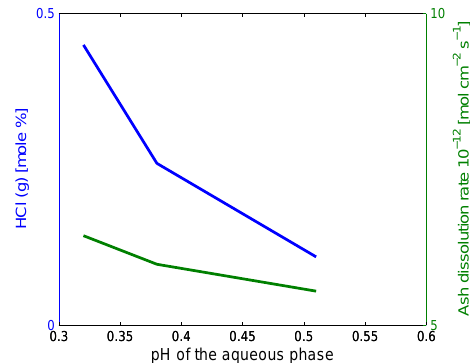
Figure 5. Vertical profile of the concentrations of major anions formed in the aqueous phase: (a) HSO − sulfuric acid dissociation; (b) HSO − and SO 2 − , which are the products of SO 2 scavenging and dissociation; and (c) Cl − and F − , which are 3 3 produced due to HCl and HF dissociation, respectively. Please note the different concentration scales. Vertical axes on left and right show the elevation and the plume temperature, respectively. Note that only the height > 9km is plotted here.